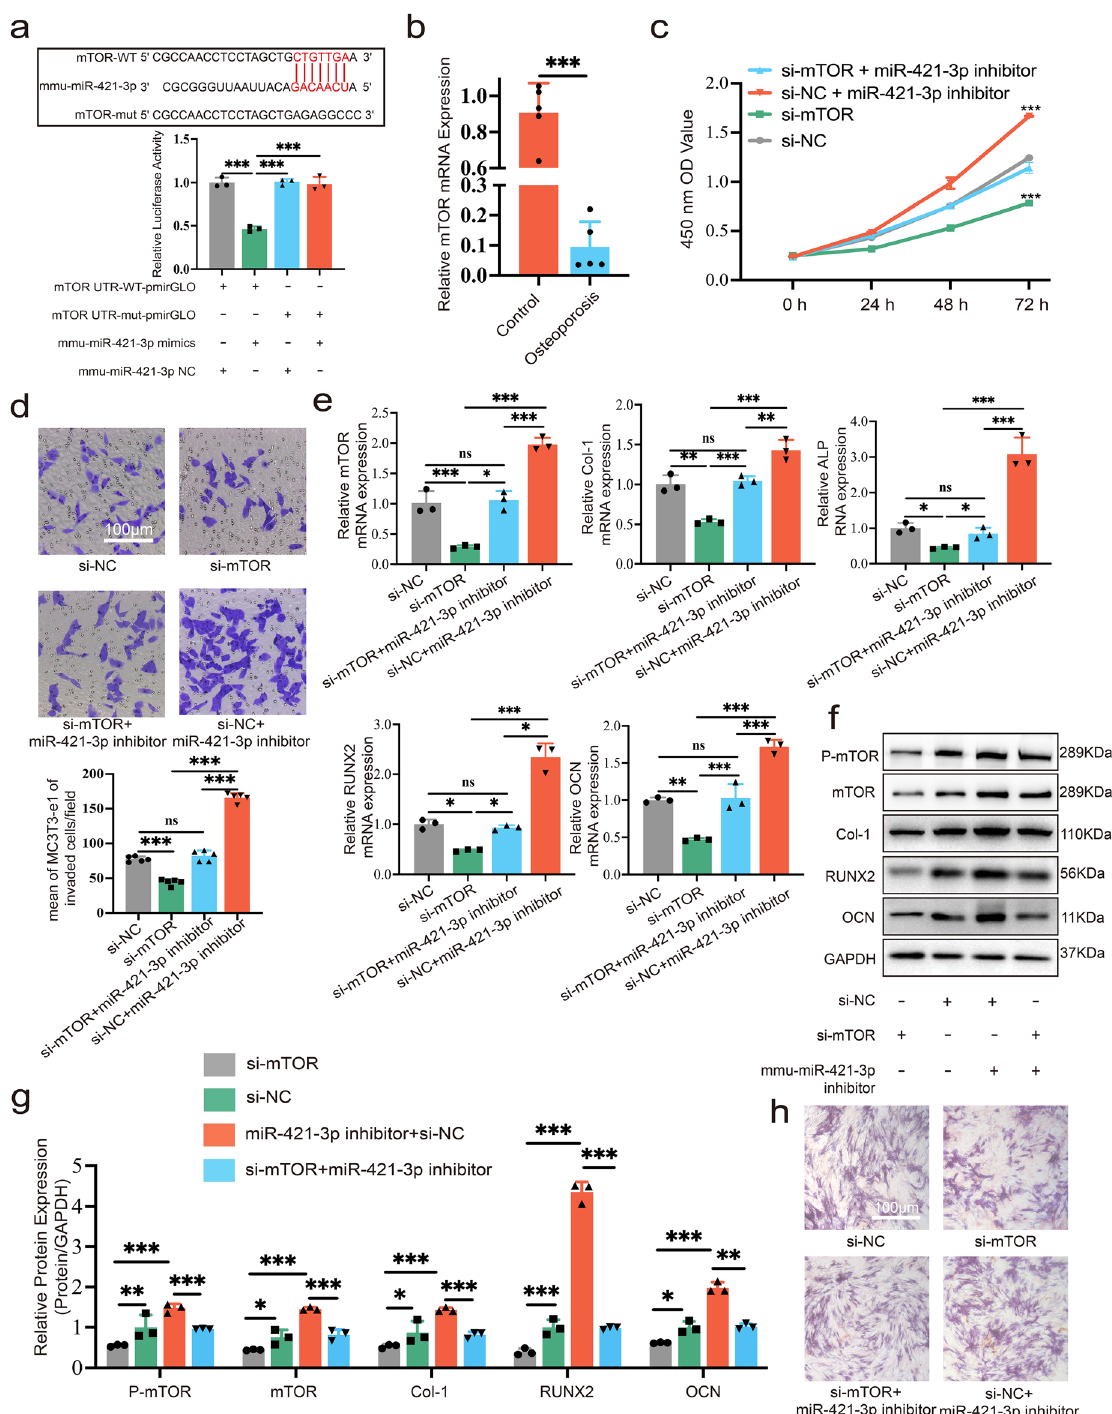
Figure 5. miR-421-3p regulates the cell viability and osteogenic differentiation of MC3T3-E1 cells by targeting mTOR. MC3T3-E1 cells were transfected with si-mTOR, si-NC, si-mTOR + miR-421-3p inhibitor or si-NC + miR-421-3p inhibitor respectively. ( a ) Starbase predicted the location of the miR-421-3p and mTOR binding site. When miR-421-3p mimics or miR-421-3p NC were transfected into mTOR WT and mut of HEK 293T cells, the relative luciferase activity was determined. ( b ) Relative mRNA expression of mTOR in bone tissue of patients with osteoporosis and controls without osteoporosis (N = 5). ( c ) CCK-8 assay showed the changes on proliferation after MC3T3-E1 cells transfection. ( d ) Transwell assay was used to demonstrate the influence on MC3T3-E1 cells’ ability to migrate. ( e ) mRNA expression of mTOR, Col-1, RUNX2, ALP and OCN detected by qRT-PCR. ( f , g ) Protein expression levels of pmTOR, mTOR, Col-1, RUNX2 and OCN of MC3T3-E1 cells after transfection and cultured in osteogenic induction medium for seven days. Uncropped Western blot images are shown in Supplementary Fig. 7. ( h ) ALP levels of MC3T3-E1 cells after transfection and osteogenic differentiation for seven days was displayed using ALP staining. *P < 0.05, **P < 0.01, ***P <